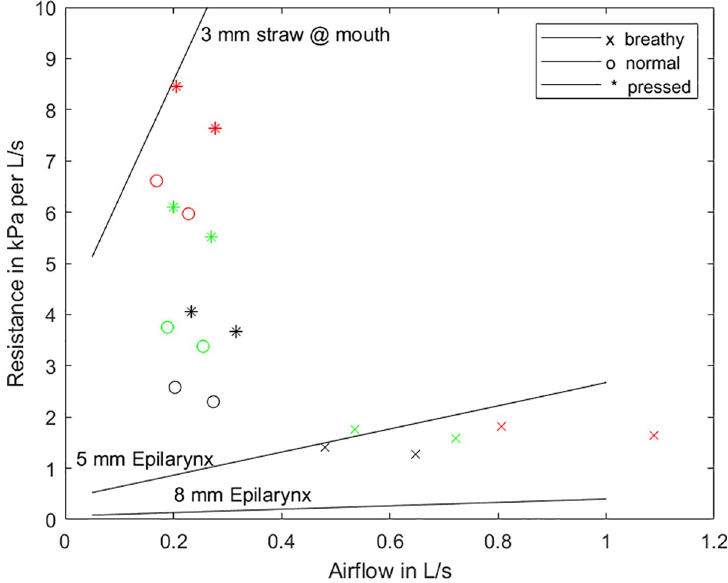
Fig 6. Steady flow resistances for the glottis at 3 loudness levels (soft—black, medium—green, loud—red) and 3 phonation types (data points), the epilaryngeal airway (lower lines), and the flow resistant tube (upper line).